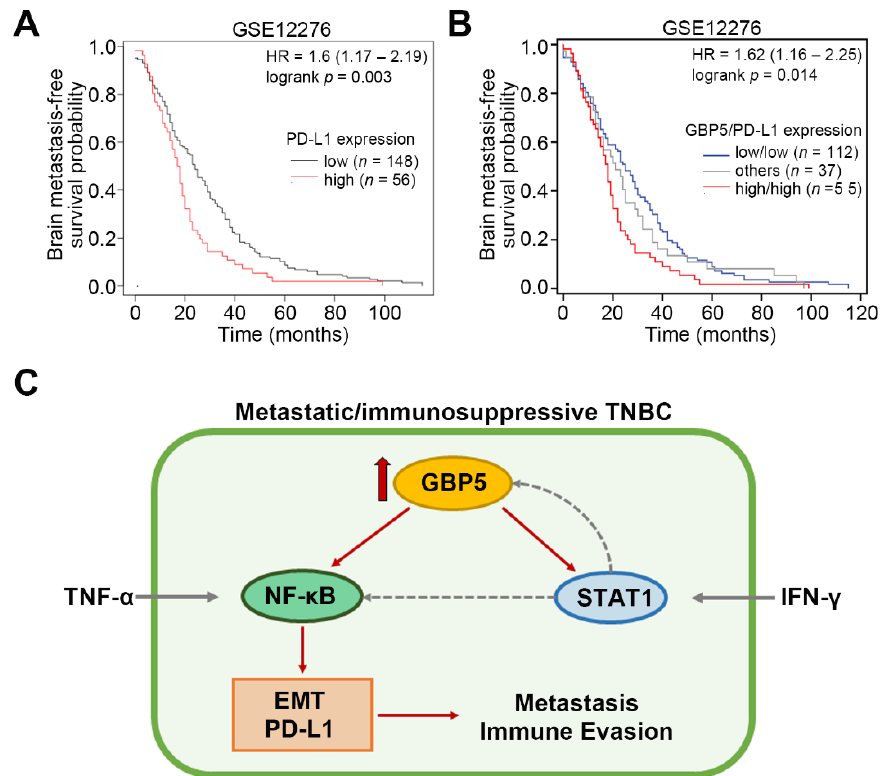
Figure 6. The signature combining higher levels of GBP5 and PD-L1 transcripts correlates with the shortest time interval for brain metastasis in breast cancer patients. ( A and B ) Kaplan–Meier analyses for PD-L1 transcripts without ( A ) or with ( B ) the combination of GBP5 expression using disease-free brain metastasis-free survival conditions under a minimized log-rank p value against breast cancer patients derived from GSE12276 datasets. ( C ) A possible mechanism for GBP5-promoted metastasis and immunosuppression in TNBC.